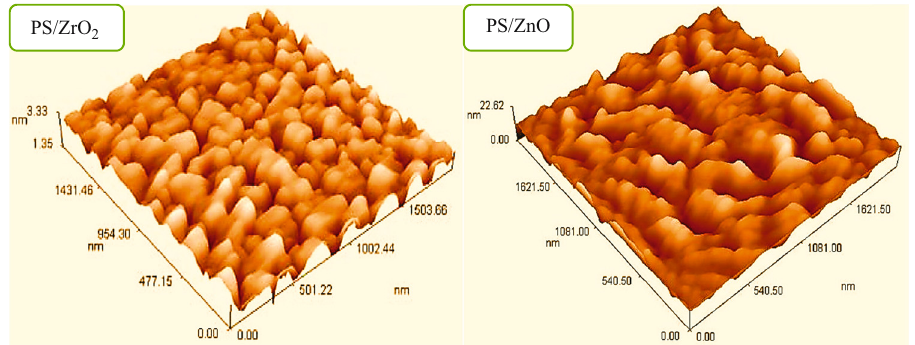
Figure 7: AFM images for PS/ZrO 2 and